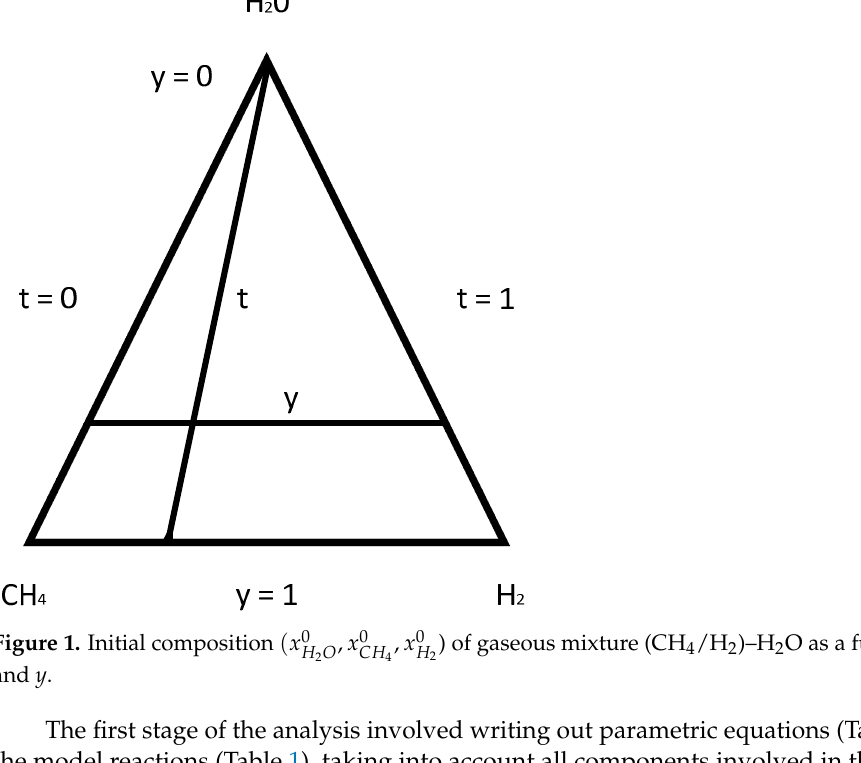
4 /H 2 )–H 2 O as a function of t